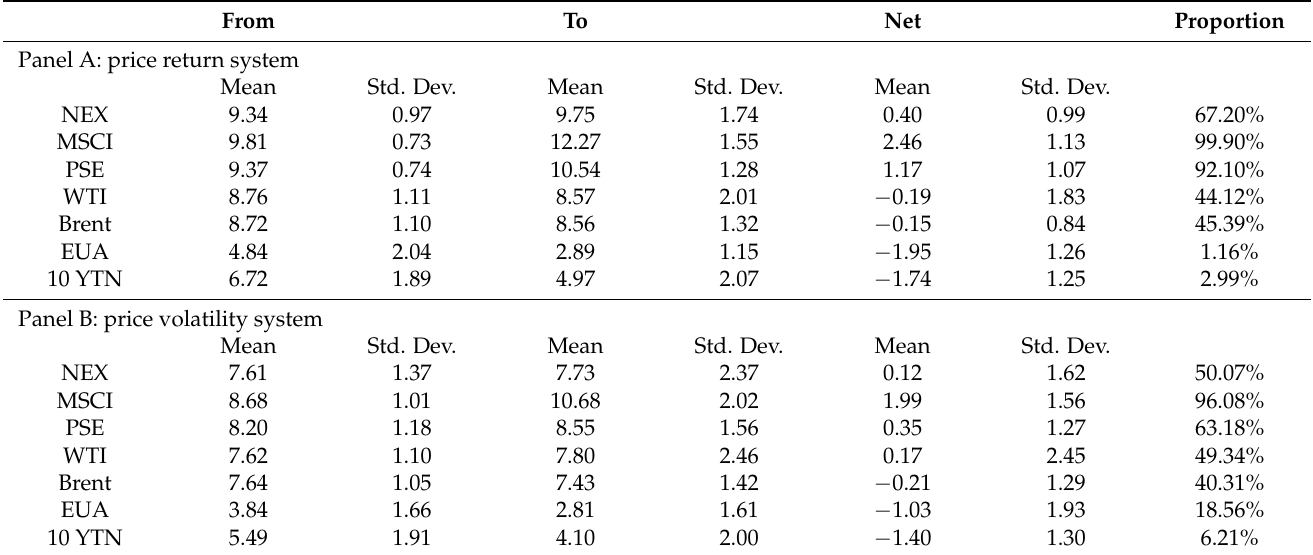
Table 3. Summary statistics of dynamic